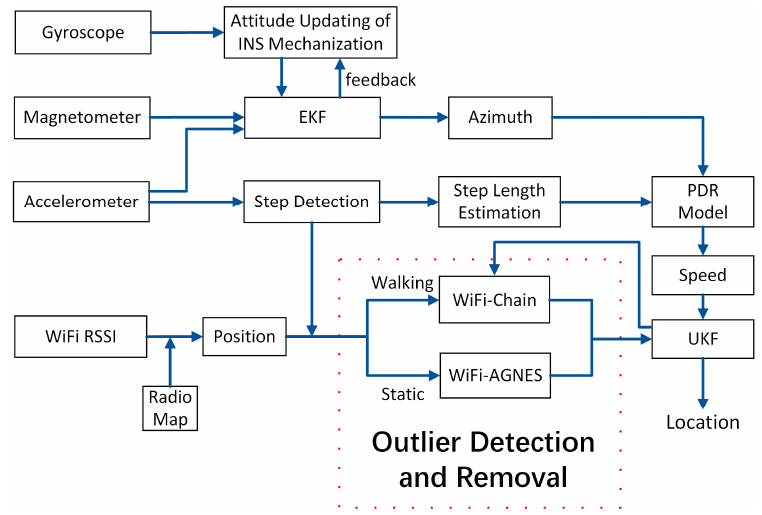
Figure 5. The architecture of the proposed hybrid fusion scheme.